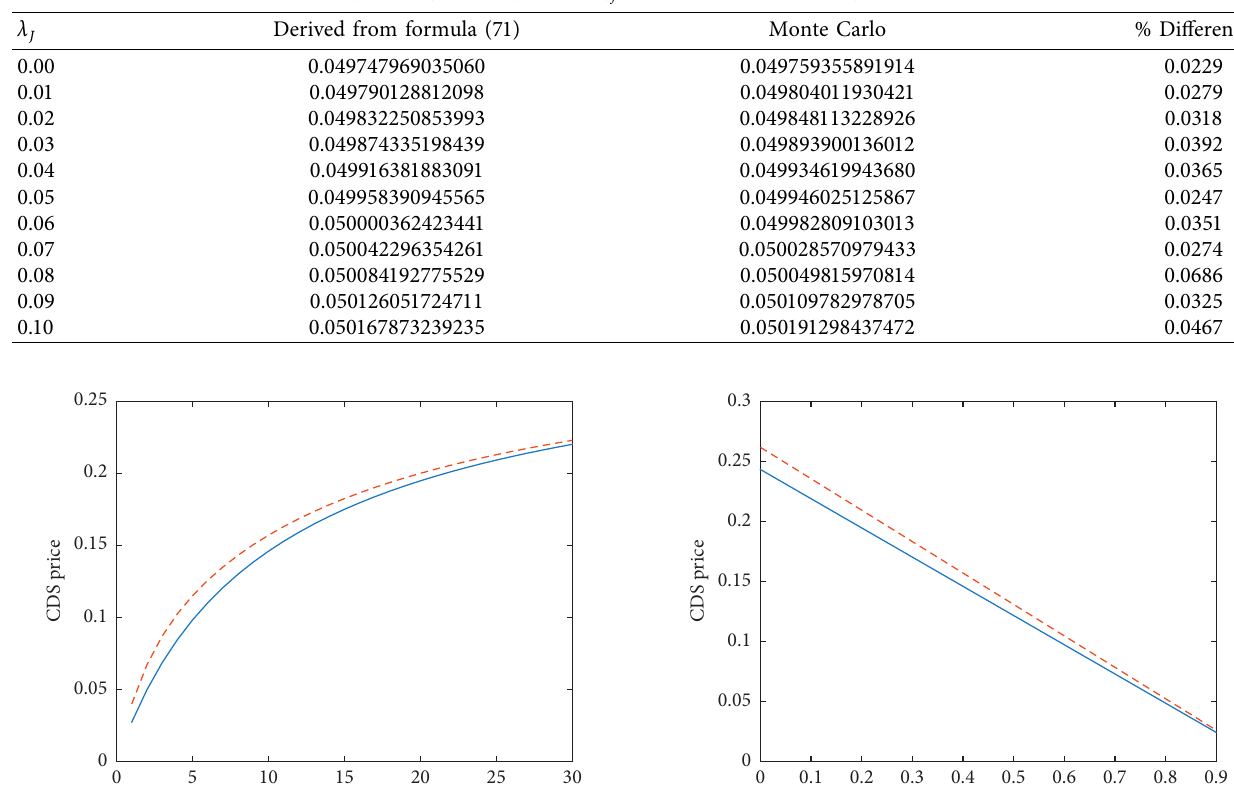
Table 1: Compare the CDS prices derived from formula (71) and that from Monte Carlo method. Parameters values are L � 1 , n � 2 ,R � 0 . 4 , r � 0 . 05 , T � 5 , a